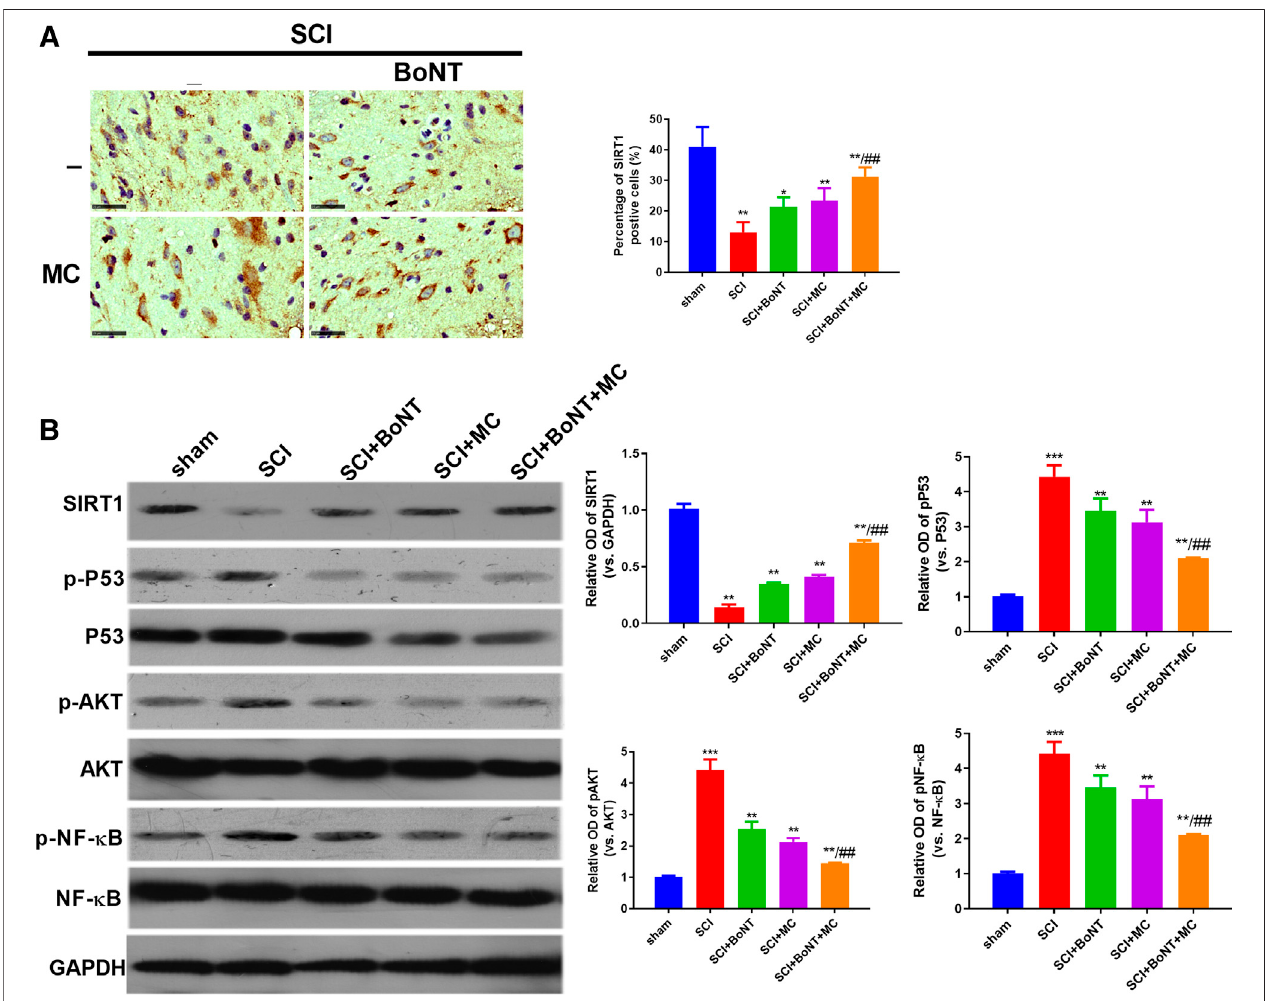
FIGURE 3 | Combination of BoNT and MC dramatically activated SIRT1 and dampened AKT. (A) IHC was adopted to detect alteration in SIRT1 expression in injured surrounding tissues after SCI. (B) Western blot was used to detect the expression changes of SIRT1, AKT, P53, NF- κ B and its phosphorylation after SCI (* p < 0.05, ** p < 0.01, *** p < 0.0001 V.S sham; # p < 0.05, ## p < 0.01, ### p < 0.0001 V.S SCI, N (cid:2)